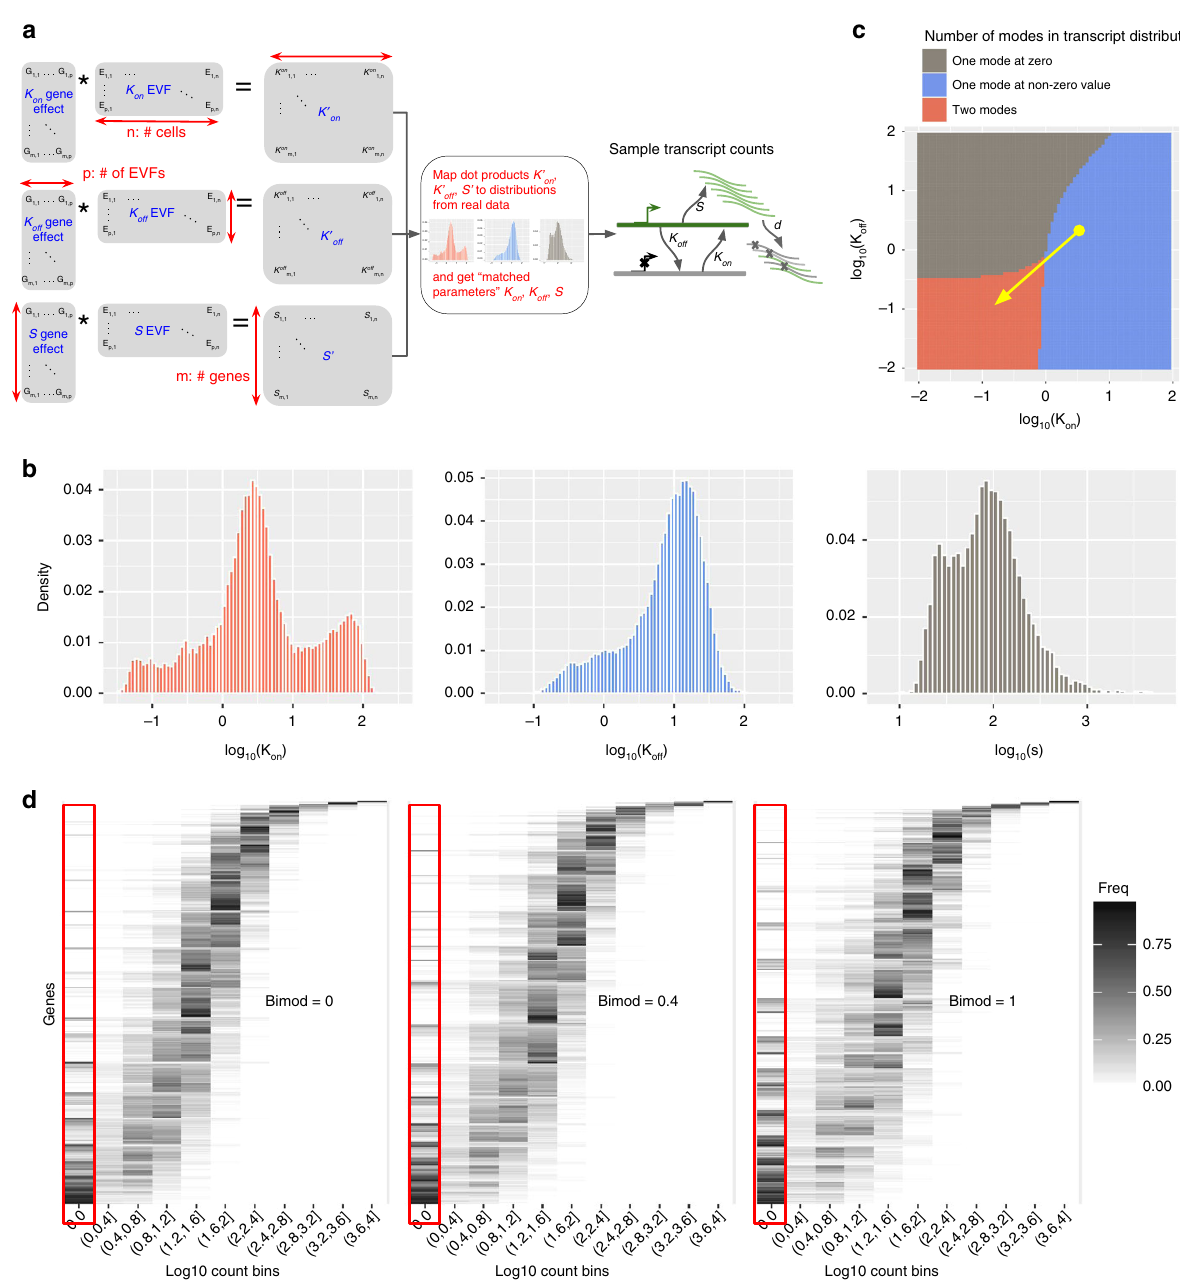
Fig. 2 Intrinsic variation. a A diagram of how gene and cell-speci fi c kinetic parameters are simulated from cell-speci fi c EVF and gene-speci fi c gene effect vectors, and how the kinetic parameters are used in a model of transcription. Each cell has a separate EVF vector for K on , K off , and S . Each parameter is generated through two steps: fi rst, for each gene in each cell, we take the dot product of the corresponding EVF and gene effect vectors. Second, the dot product values are mapped to distributions of parameters estimated from experimental data. The matched parameters are used to generate true transcript counts (see Methods). b The distributions of k on , k off , and s that are used in SymSim for simulations. These distributions are aggregated from inferred results of three subpopulations of the UMI cortex dataset (oligodendrocytes, pyramidal CA1 and pyramidal S1) after imputation by scVI and MAGIC. c A heatmap showing the effect of parameter k on and k off on the number of modes in transcript counts. The value of s is fi xed to 10 in this plot. The red area with low k on and k off have one zero mode and one non-zero mode. The gray area with low k on and high k off has only one zero mode, and the blue area with high k on and low k off have one non-zero mode. The yellow arrow shows how the parameter bimod can modify the amount of bimodality in the transcript count distribution. d Histogram heatmaps of transcript count distribution of the true simulated counts with varying values of bimod , showing that increasing bimod increases the zero-components of transcript counts and the number of bimodal genes. In these heatmaps, each row corresponds to a gene, each column corresponds to a level of expression, and the color intensity is proportional to the number of cells that express the respective gene at the respective expression level. Data used to plot b – d can be found in Source Data